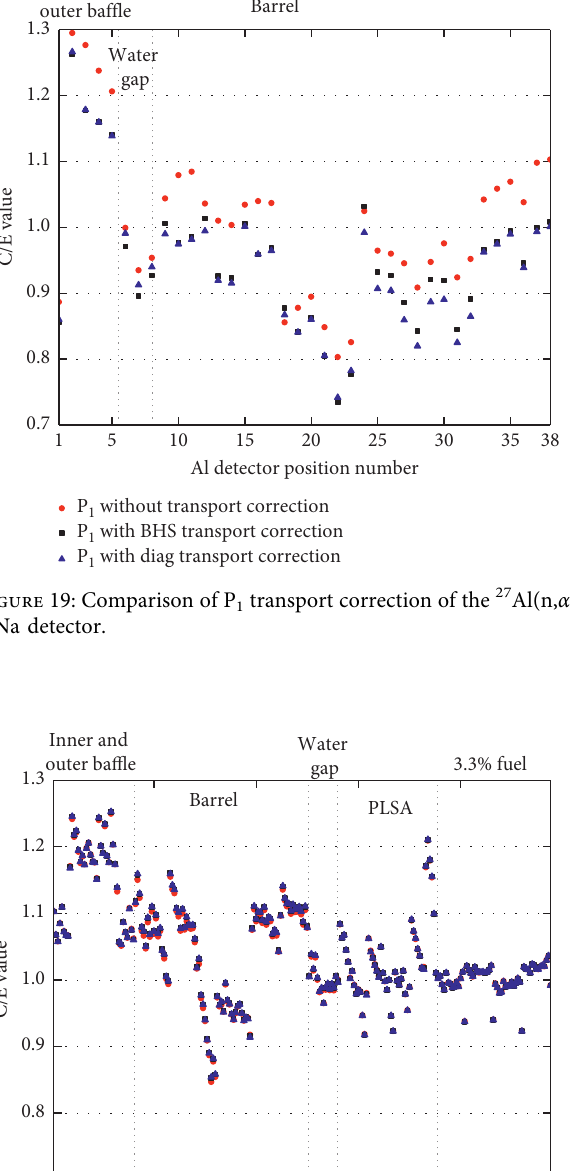
Figure 20: Comparison of P 58 Co detector.